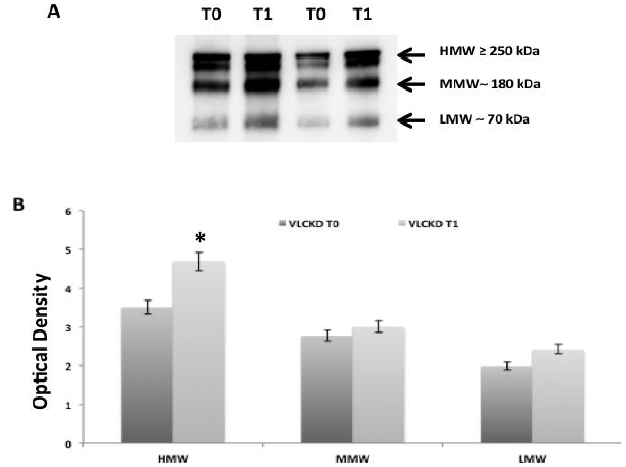
Figure 4. Improvement of adiponectin oligomeric profile after eight weeks of VLCKD. Adiponectin oligomers, analyzed by Western blotting ting, increased in the adiponectin from VLCKD participants after eight weeks of VLCKD (T1). ( A ) A representative blot of different oligomers of adiponectin (high, medium, and low molecular weight (HMW, MMW, and LMW)) in the serum of two VLCKD participants at baseline (T0) and after eight weeks of VLCKD intervention (T1). ( B ) Graphical representation of pixel quantization of all VLCKD participants at baseline (T0) and eight weeks after VLCKD intervention (T1).